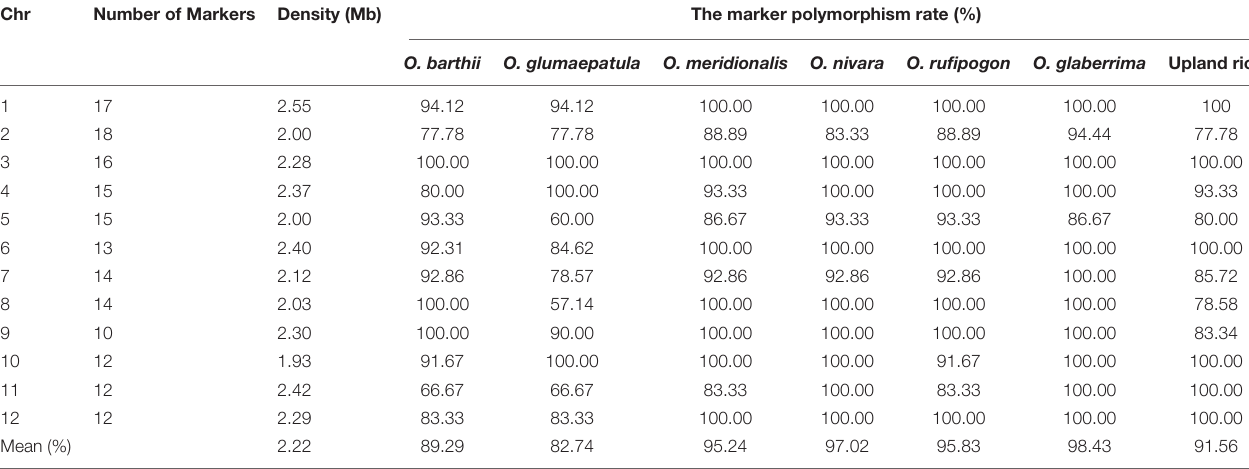
TABLE 1 | The description of markers used for genotyping introgression library. Chr Number of Markers Density (Mb)